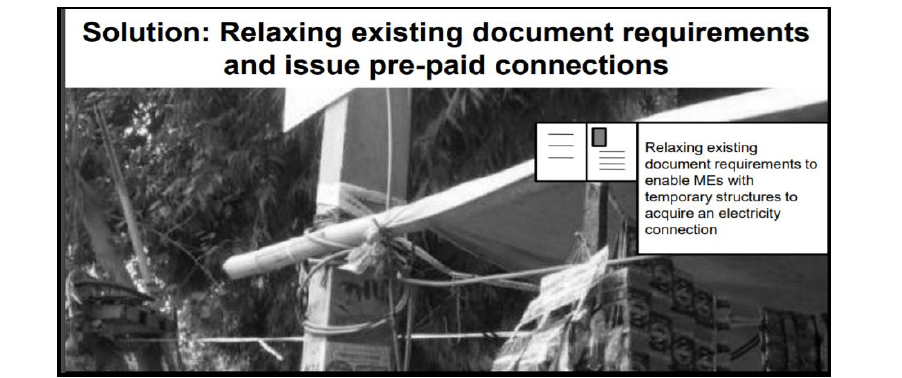
Fig. 2. AI Camera for data analysis